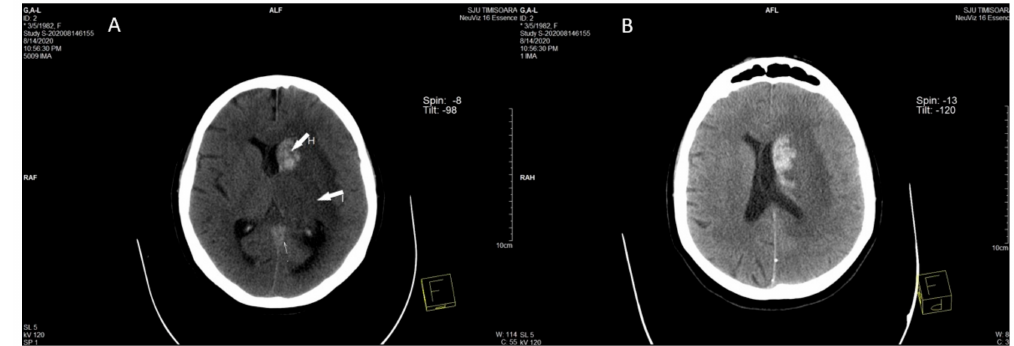
Figure 2. ( A ) Axial unenhanced head CT performed in the acute phase shows venous infarction (I) in the left thalamus, left basal ganglia, left external and internal capsule, and corona radiata. ( A , B ) Hemorrhagic transformation (H) can be seen in the head and corpus of the left caudate